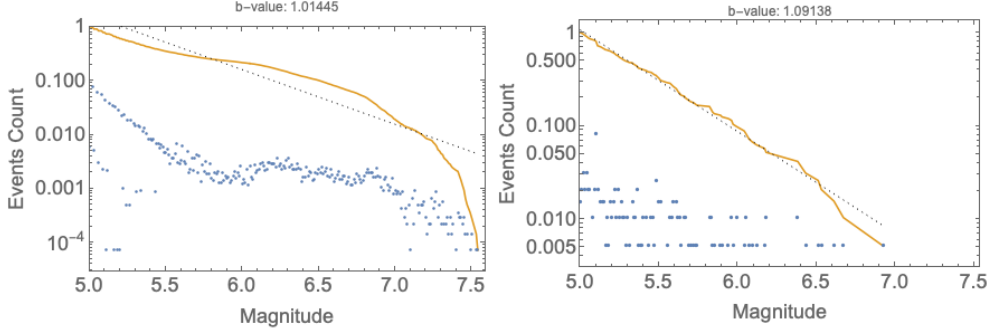
Figure 4. Cumulative (yellow line) and density (blue dots) Magnitude–Frequency Distributions (MFD) of M w ≥ 5.0 earthquakes of 100,000 years simulated ( left panel ) and observed ( right panel ; CPTI15 from 1650 to 2020 AD) catalogs. Straight dotted lines show best-fit of cumulative distributions.